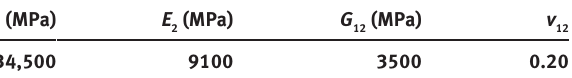
Table 1 Mechanical properties of the composite